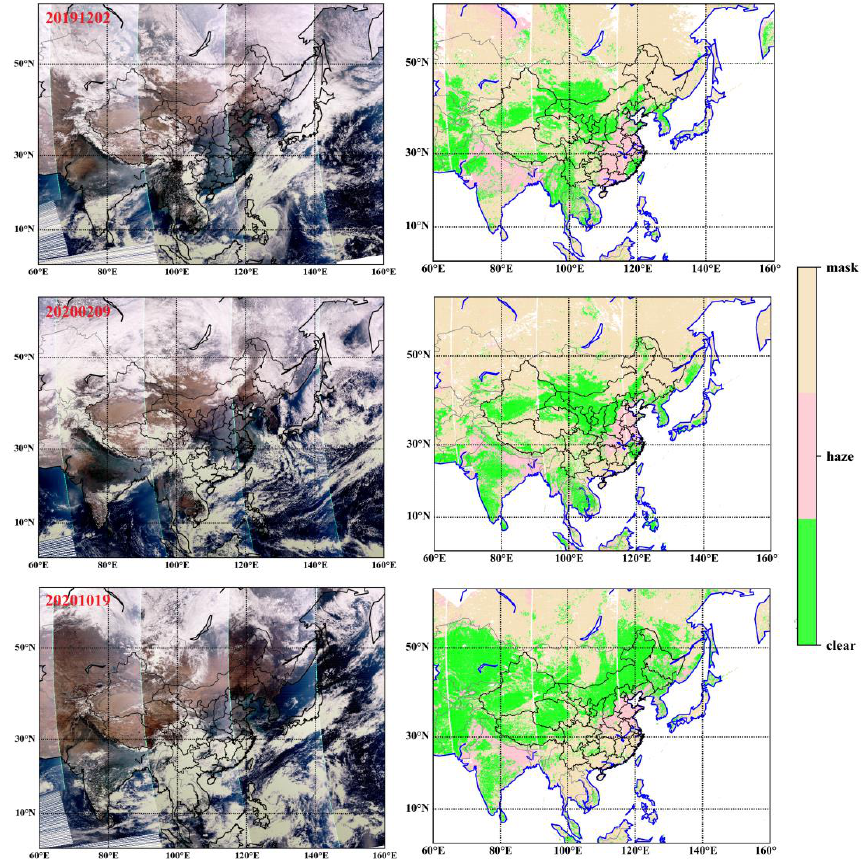
Figure 8. True color map and corresponding identification map based on MHAM algorithm, these three rows represent the distributions on 2 December 2019, 9 February 2020 and 19 October 2020, respectively.